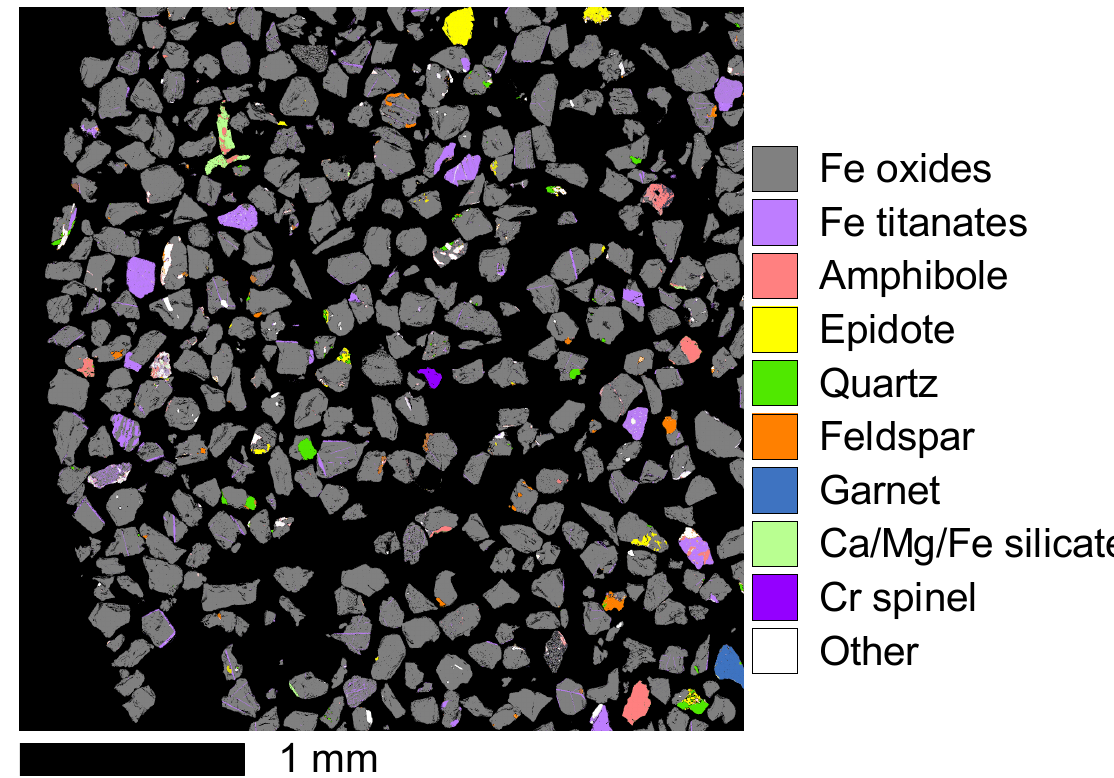
Figure 11. EPMA map results for the magnetite concentrate showing the phase patched map with the distribution of all phases present in the sample. Only phases with an abundance of >1% by area are shown. Trace phases are labelled as ‘Other’. Operating conditions for the microprobe during mapping were an accelerating voltage of 20 keV, a beam current of 80 nA, a step size of 2 µm (in x and y) and a counting time of 15 ms per step.